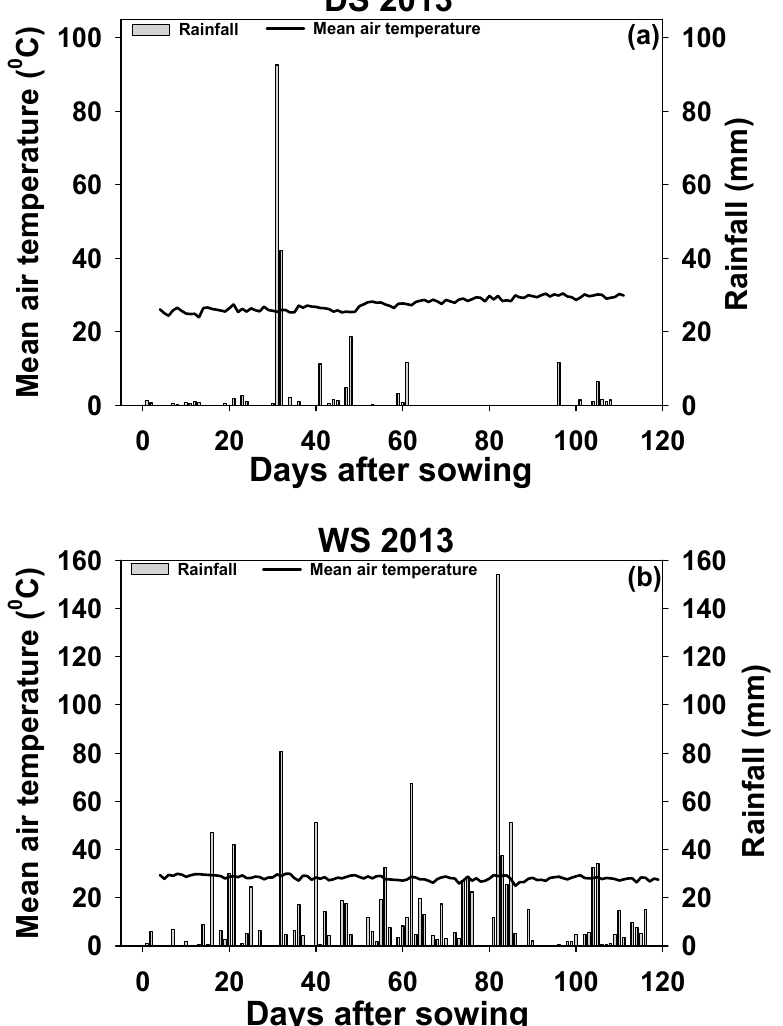
Figure 1. Mean air temperature (°C) and rainfall (mm) during the whole growth period. ( a ) Mean air temperature (°C) and rainfall (mm) during dry season; ( b ) Mean air temperature (°C) and rainfall (mm) during wet season.